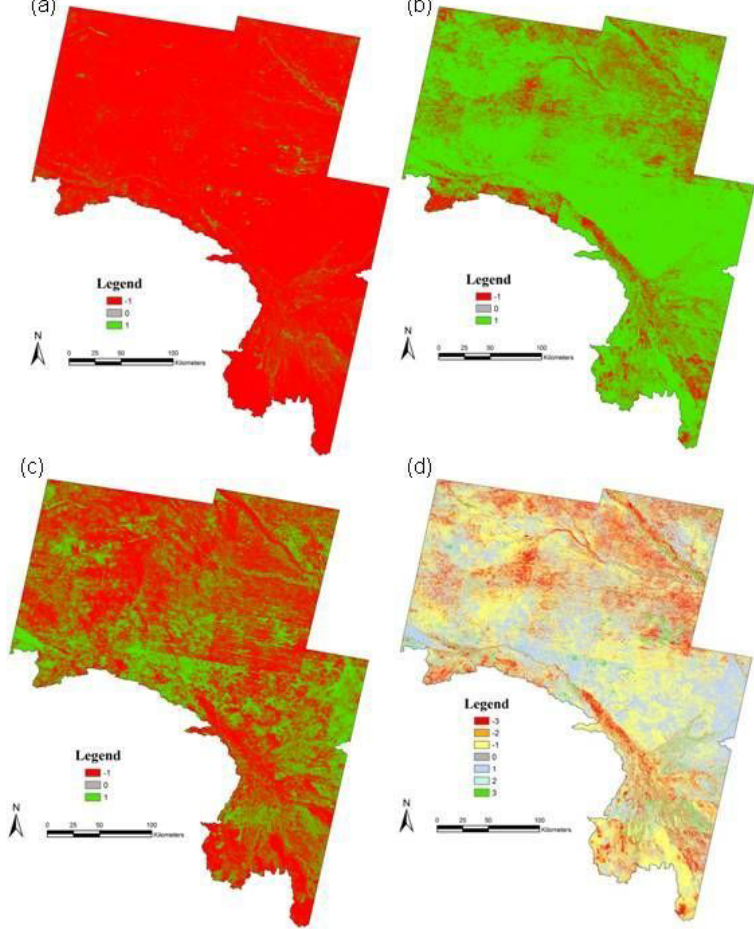
Figure 9. Results from the NDVI persistence analysis for each of the time steps: ( a ) 1970–1984, ( b ) 1984–1990 and ( c ) 1990–2009; ( d ) cumulative change in NDVI